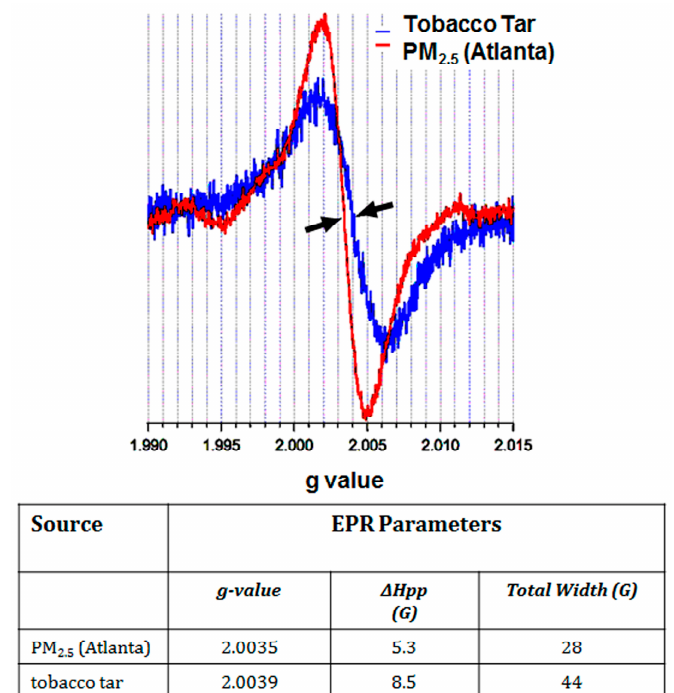
Figure 1. EPR spectra of ambient air PM 2.5 (Atlanta) and cigarette tar, with a centerfield of 3550 Gauss. In both cases, the observed spectra is typical of an EPFR. The larger width of the tobacco tar signal is indicative of more complex convolution due to the presence of multiple radicals. Arrows point to the g-value for each spectrum.